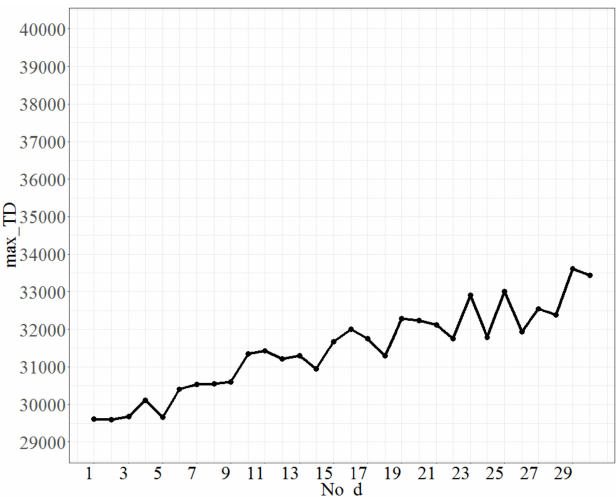
Figure 5. The plot of max_TD as No_d